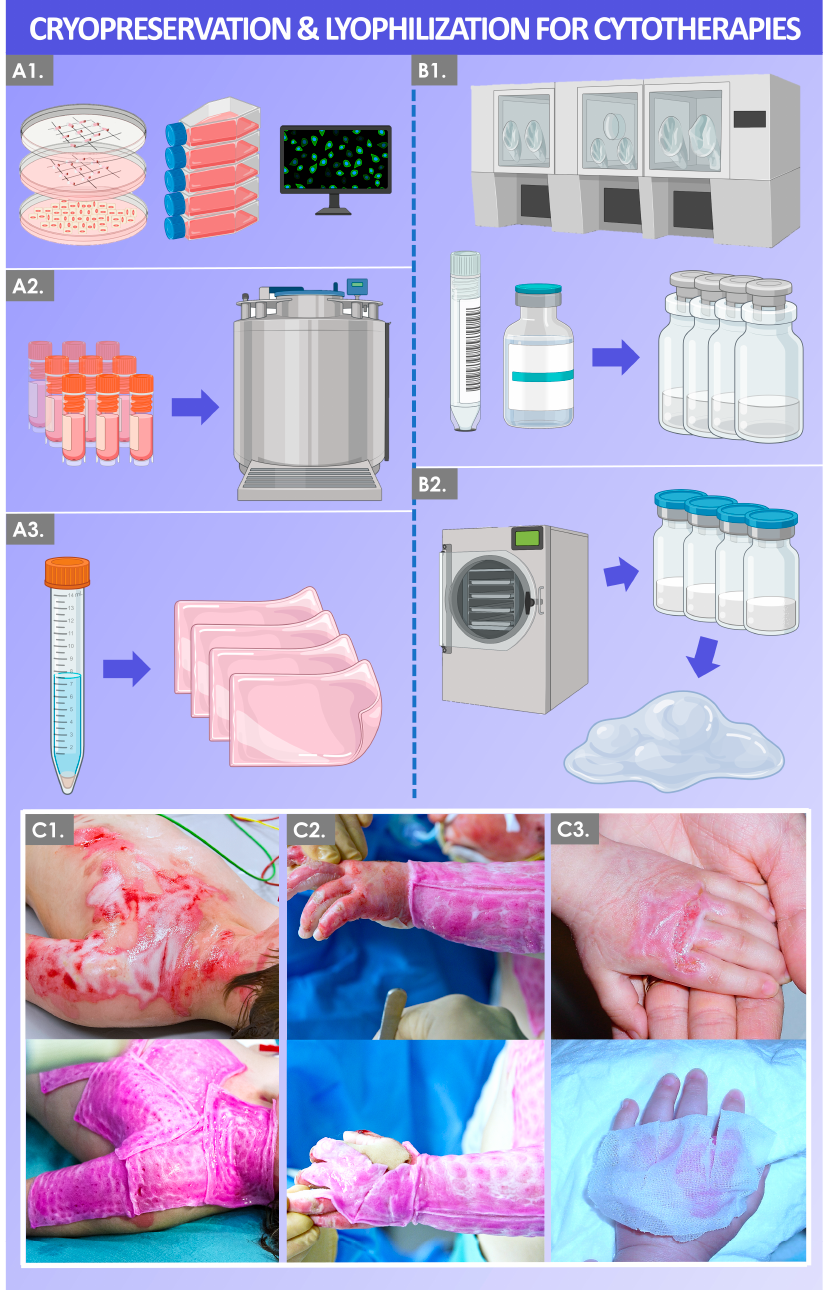
Figure 1. Schematic and illustrative workflow of cryopreservation ( A1 – A3 ) and lyophilization ( B1 , B2 ) processes used in the manufacture of topical cytotherapies or derivatives for cutaneous